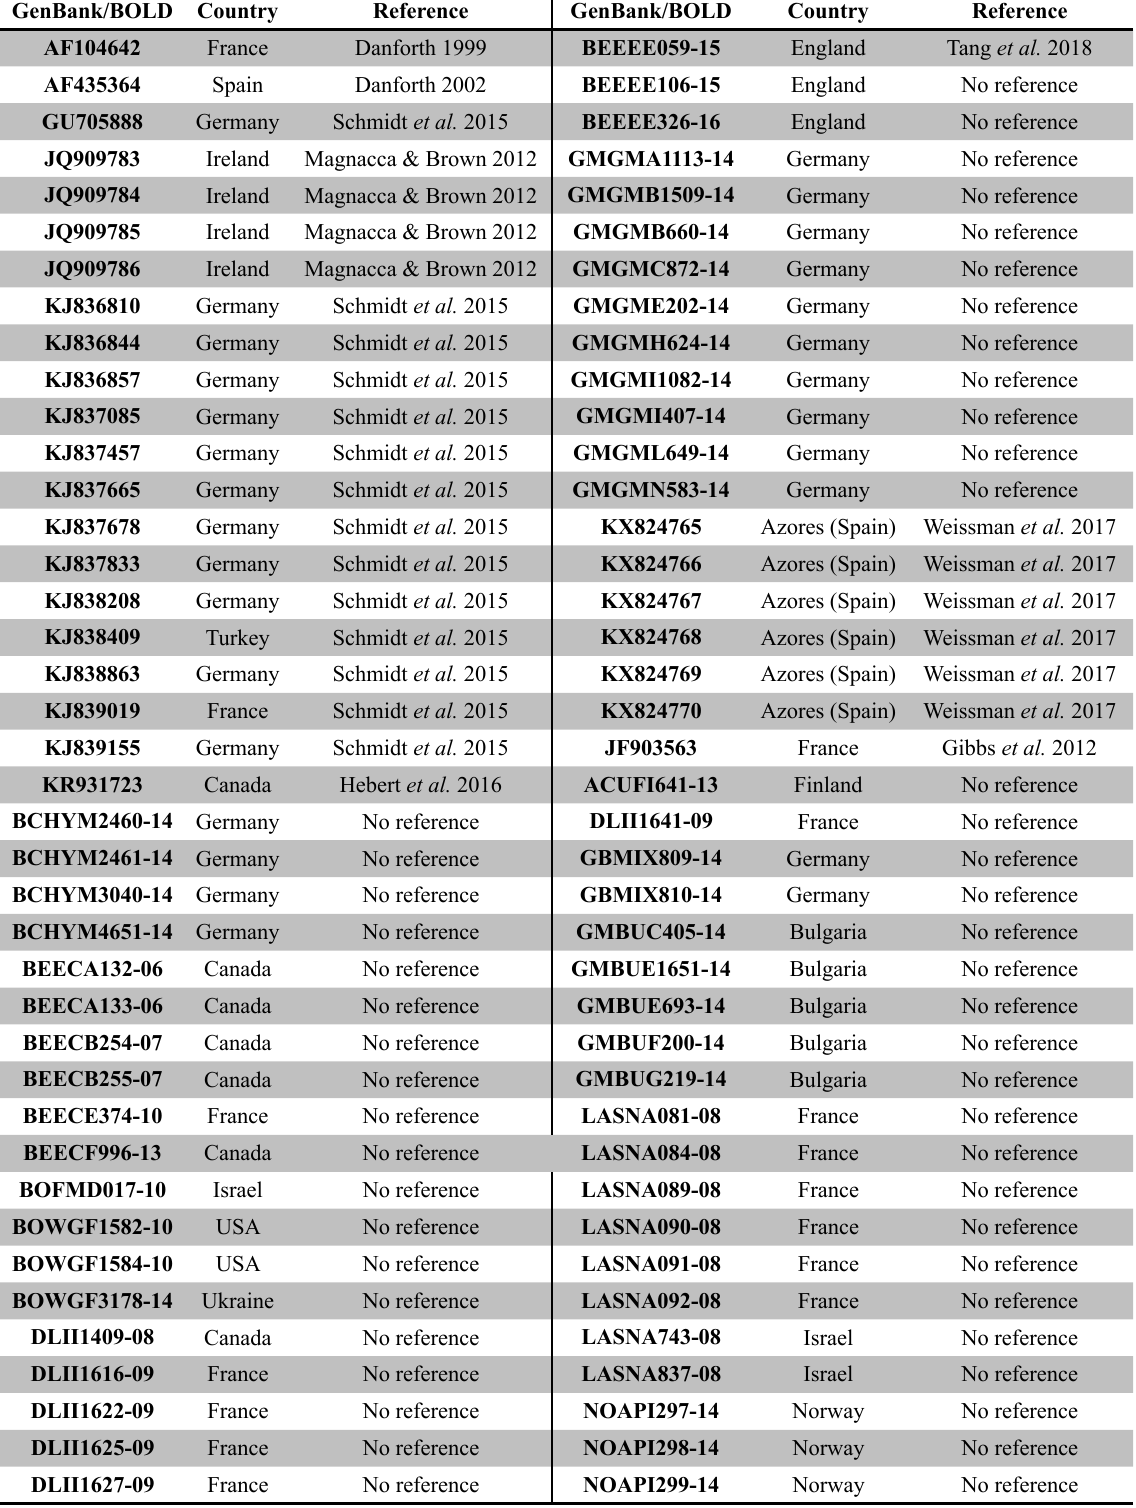
Table 2. Barcodes sequences of Lasioglossum villosulum (Kirby, 1802) retrieved from GenBank and BOLD with their accession number or BOLD process ID, collection country and